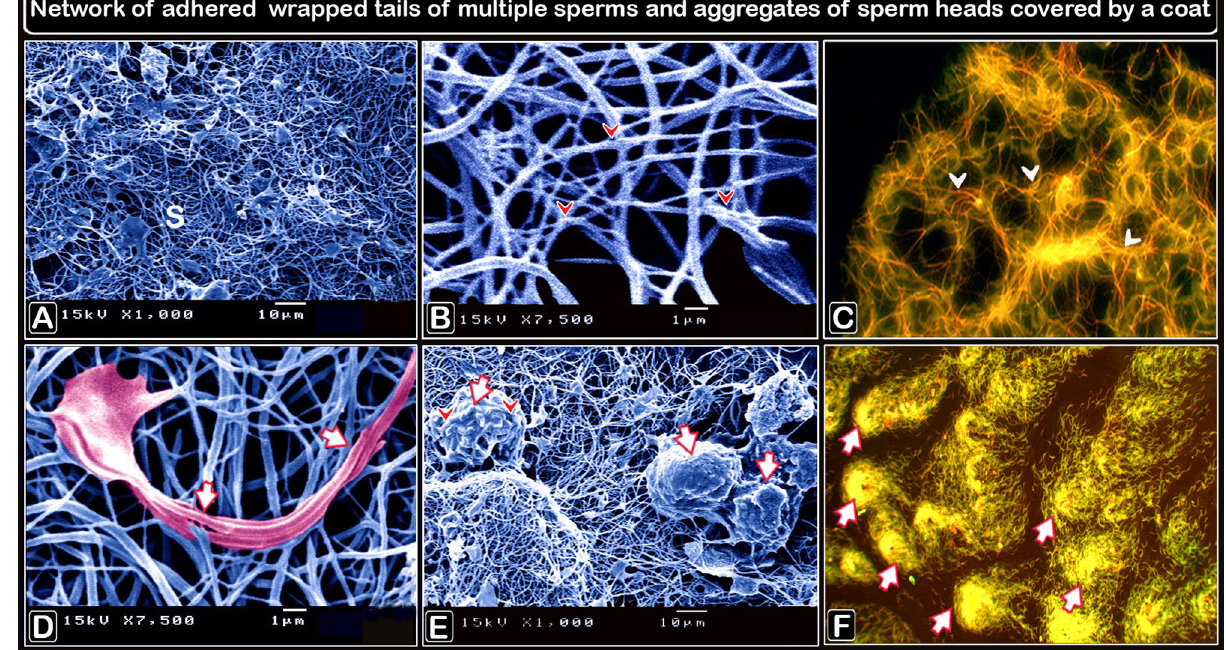
Figure 4. Scanning electron micrograph images of sperm bundles and an acridine orange-stained sperm smear. ( A , B , D , E ) are digitally colored scanning electron micrographs of sperm, whereas C and F are micrographs of sperm smears stained with acridine orange and showing a network of adherent wrapped tails of multiple sperm. ( A – C ) Aggregations of sperm (s) shown as a network of adhered tails (arrowheads). ( D ) Multiple sperm of adhered wrapped tails (with the agglutinating substance, pink outlined, arrows). ( E and F ) Sperm head aggregates (arrows) coated by a agglutinating material (arrowheads). The sperm formed bundles with few twister-like structures ( F ). Magnification of ( C ) ×400 and ( F )